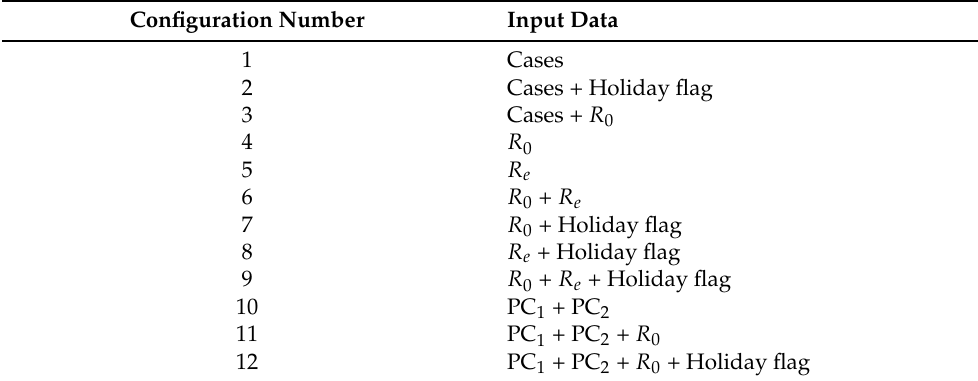
Table 5. All settings considered for the grid-searching, evaluating R 0 and R e , extracted from SEIRD Model, and Holiday flags, which is a flag value representing the holiday + 14 days subsequent, and PCs generated by the PCA method. For all configurations it proposed is to forecast the COVID-19 daily deaths for the last bi-weekly period, reserved for